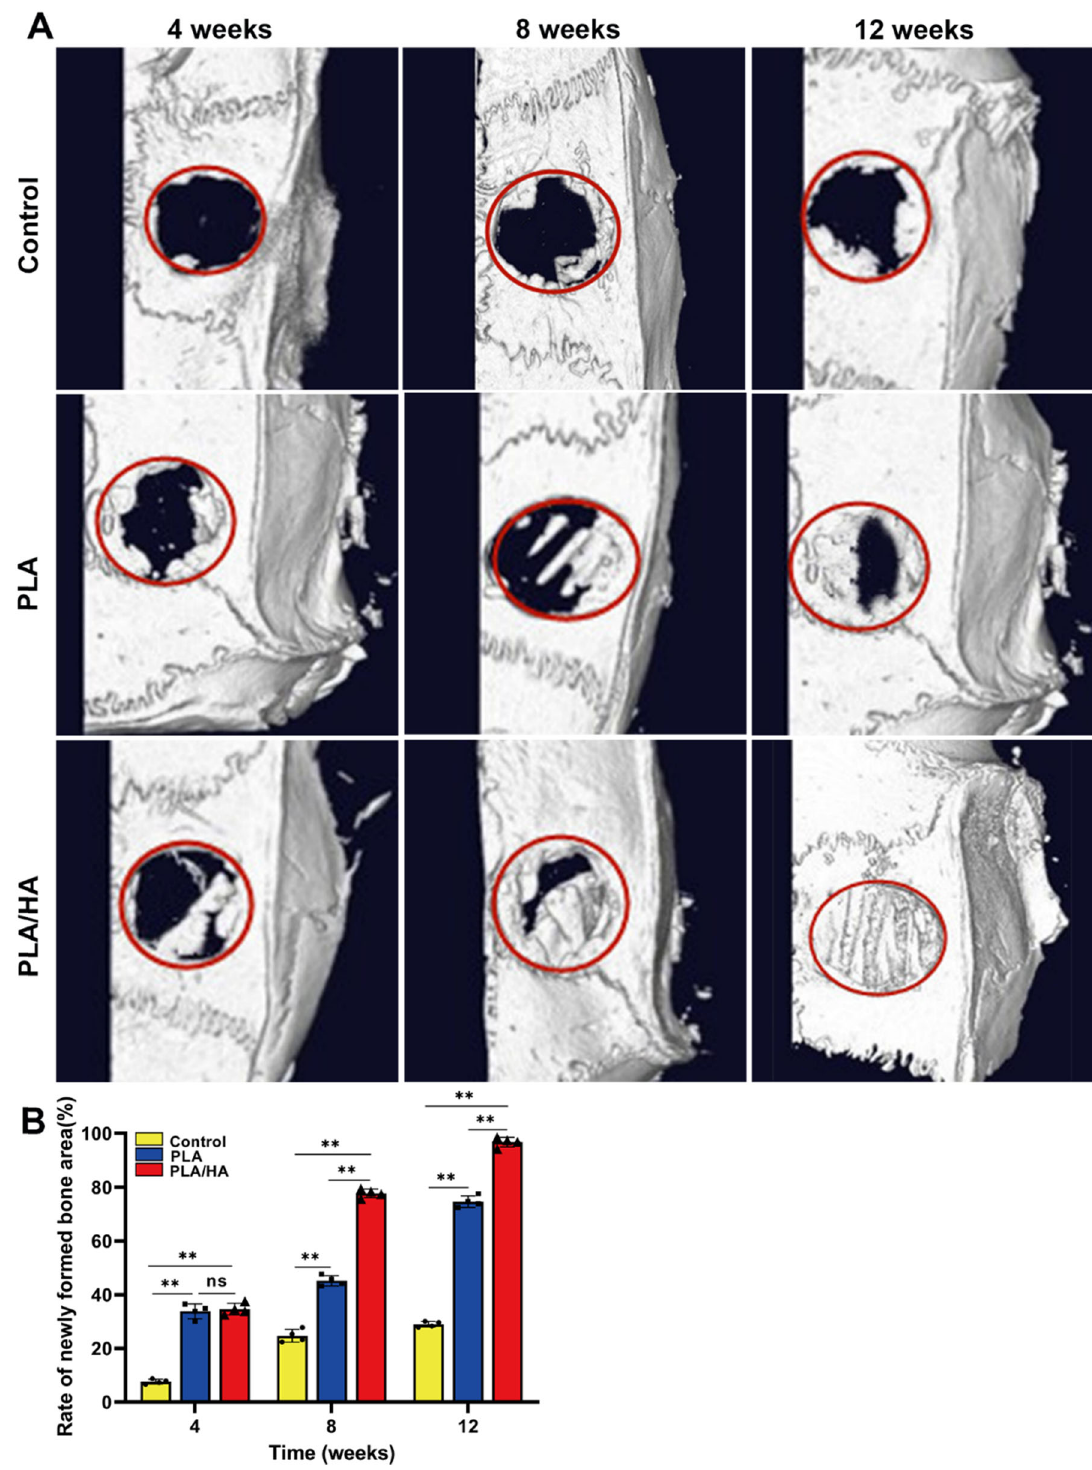
Fig. 7 A Images reconstructed by micro-CT showing bone regenera- tion in the different groups (control, PLA, and PLA/HA) at each time point (4, 8 and 12 weeks after treatment). B The rate of newly formed